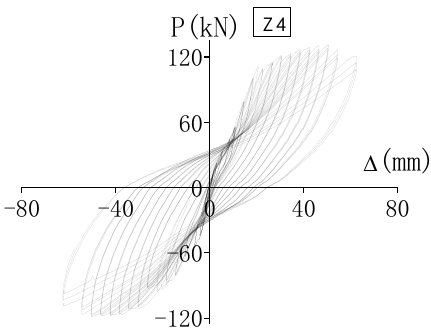
Figure 14. Hysteretic curve Z4 ( ρ = 8%, two layers).